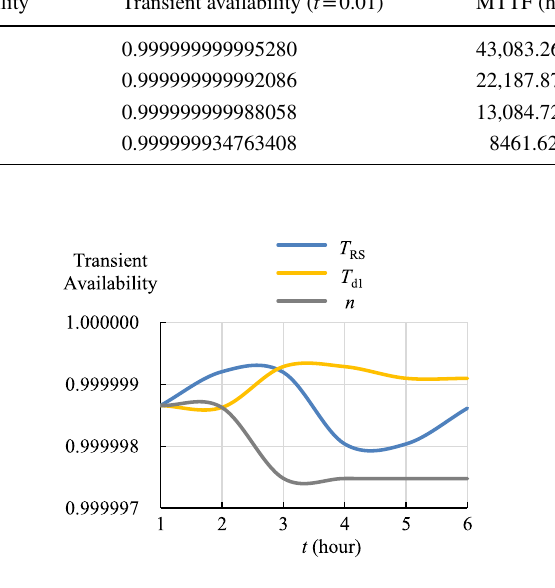
Number of VNFs Steady-state availability Transient availability ( t = 0.01) availability, transient availability and MTTF under different number of VNFs